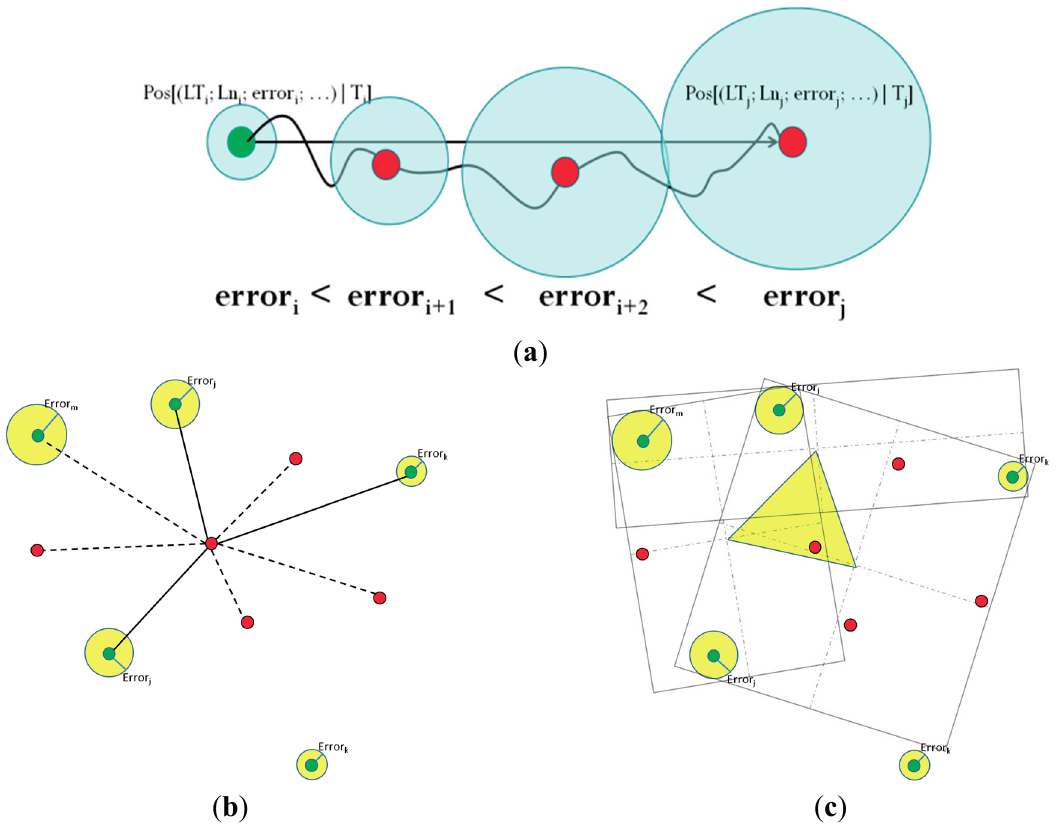
Figure 4. ( a ) Dead reckoning; ( b ) trilateration; ( c ) minimum bounding rectangle